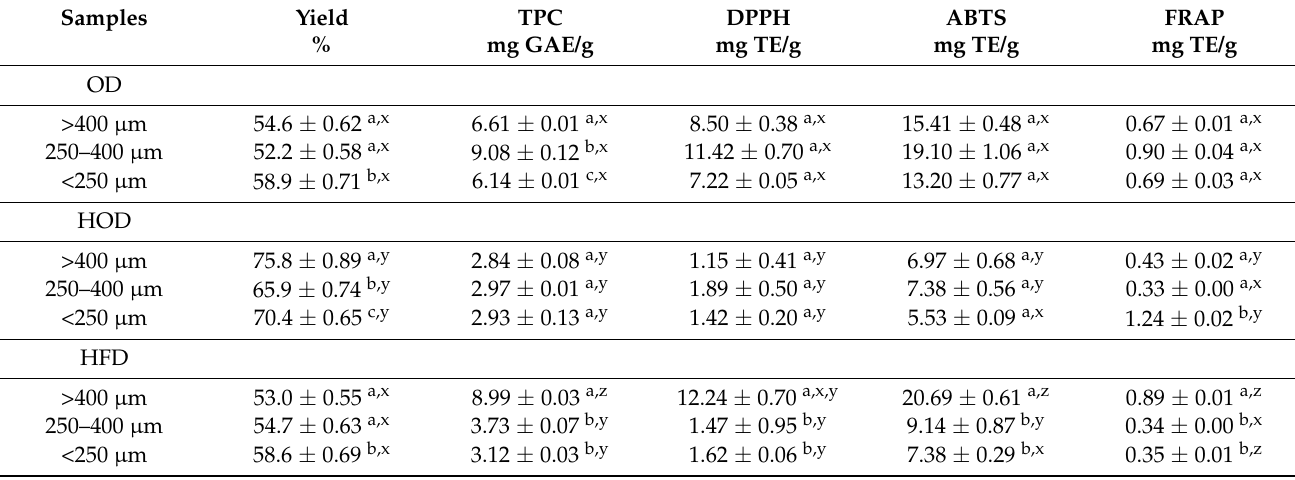
Table 2. Extraction yield (%), TPC and in vitro antioxidant activities (DPPH, ABTS, and FRAP assays) of AP samples subjected to different drying treatments (OD, HOD, and HFD) and